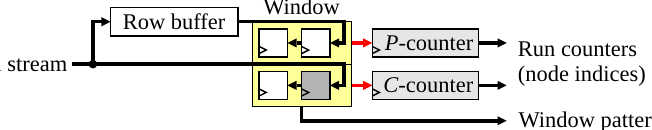
Figure 3. Architecture for constructing the 2 × 2 window and providing node indices for each run. The current pixel within the window is